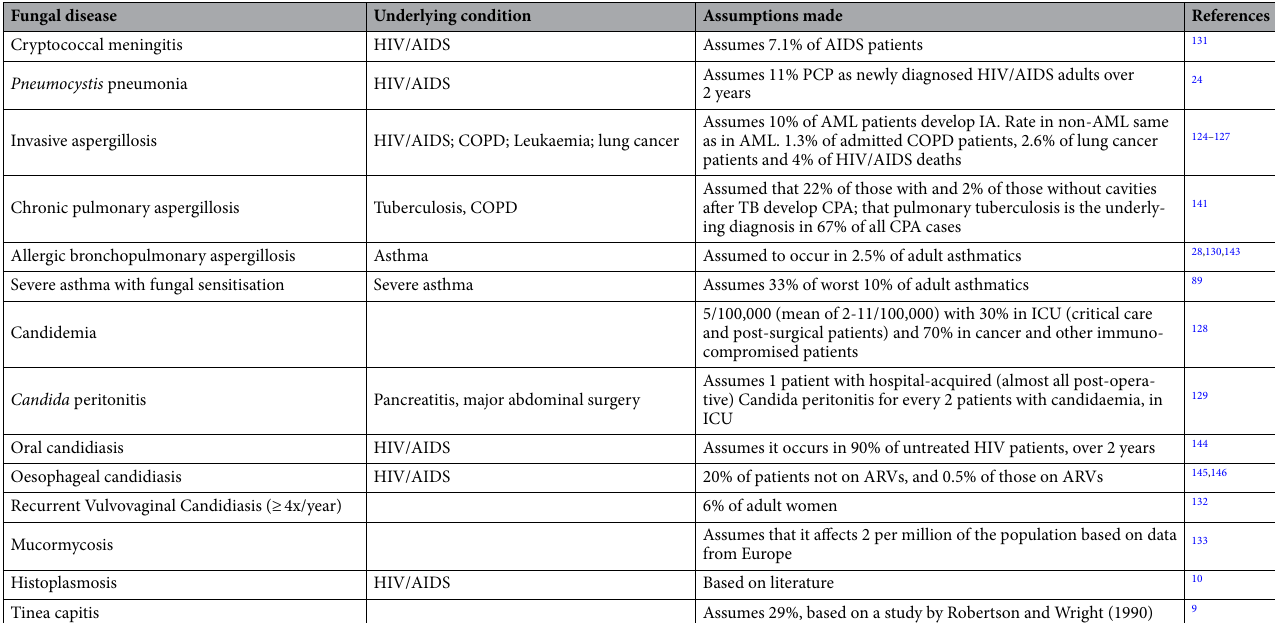
Table 5. Assumptions on which estimates of fungal diseases were made. COPD chronic obstructive pulmonary disease, CPA chronic pulmonary